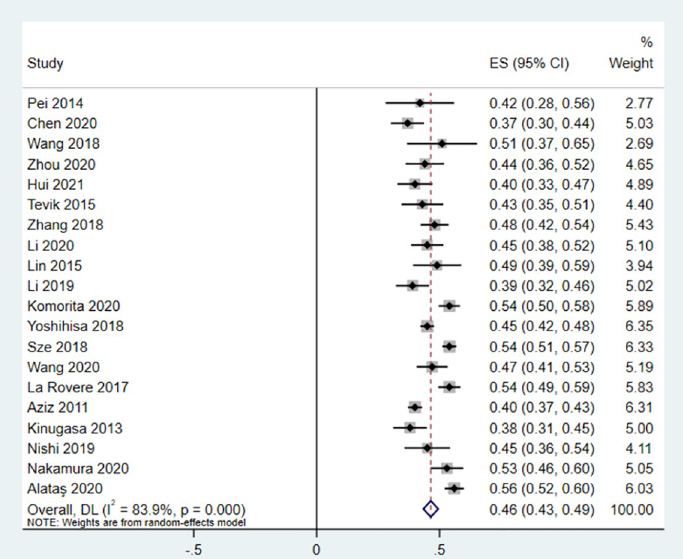
Fig 2. Forest plots of malnutrition prevalence in patients with chronic heart failure. ES: Effect Size CI: Confidence Interval DL: DerSimonian-Laird.